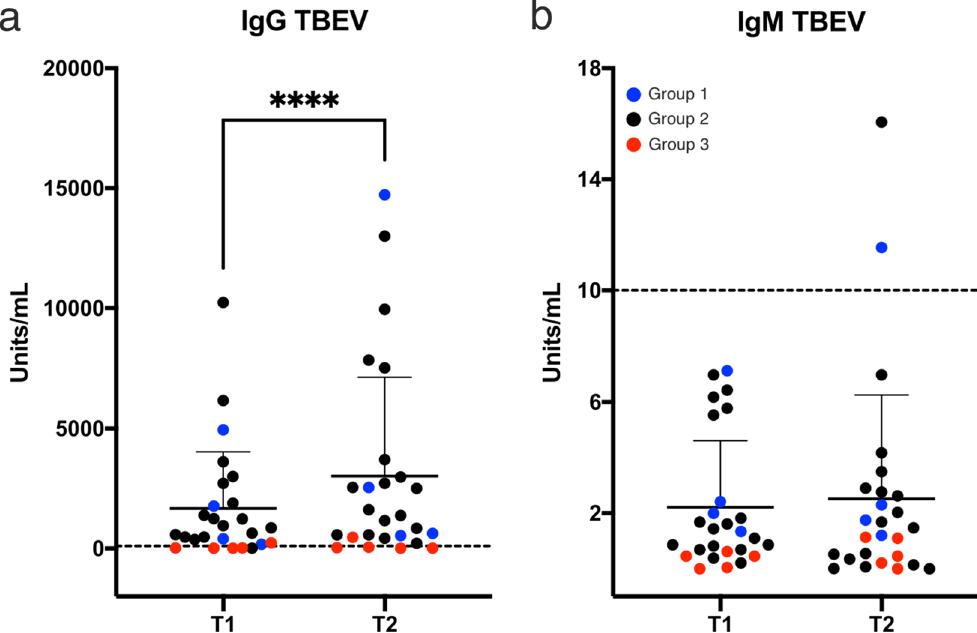
Figure 2. Significant increase was observed in anti-TBEV IgG antibodies in follow up samples . ( a ) Anti- TBEV IgG antibodies were significantly increased in follow up samples compared to baseline (T2, 16/22); **** p < 0.0001. ( b ) IgM seroconversion was observed in one sample with an equivocal increase in another. Dashed lines: Limit of negativity; IgG: 100U/ml, IgM: 10U/ml. T1 March/April 2020, T2 August/September 2020. Group 1, blue: SARS-CoV-2 convalescents, group 2, black: TBEV vaccinees, group 3, red: negative control